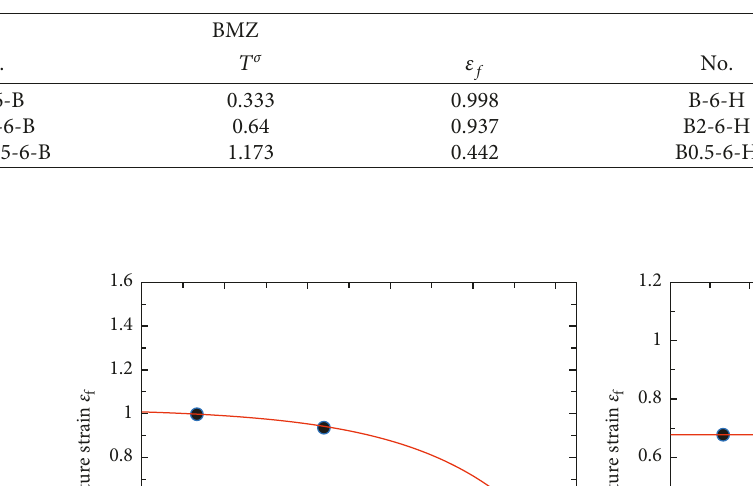
Table 3: Fracture strain of base metal and heat-affected zone